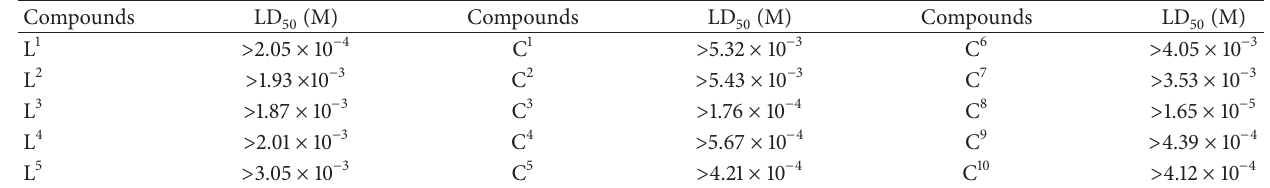
Table 3: Brine shrimp bioassay of ligands (L 1 –L 5 ) and their metal(II) complexes (C 1 –C 10 ). Compounds LD (M) 50